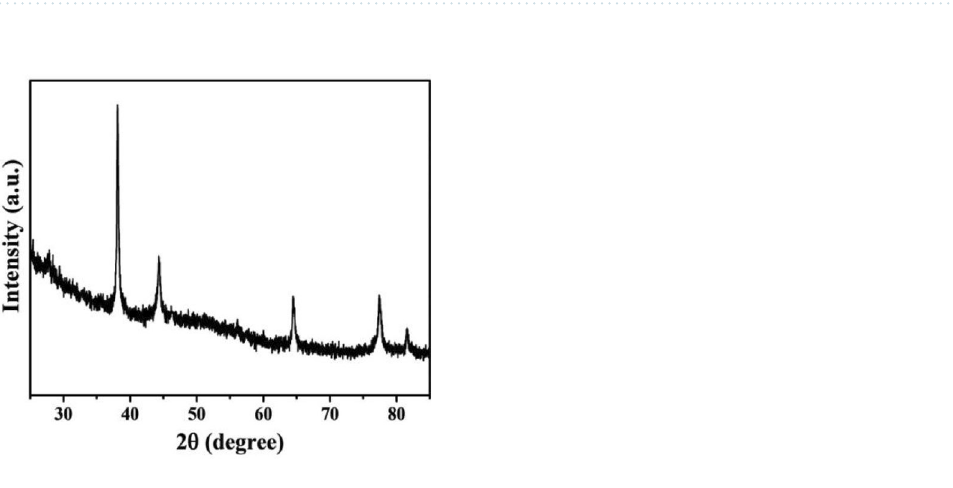
Figure 5. X-ray diffraction patterns of synthesized